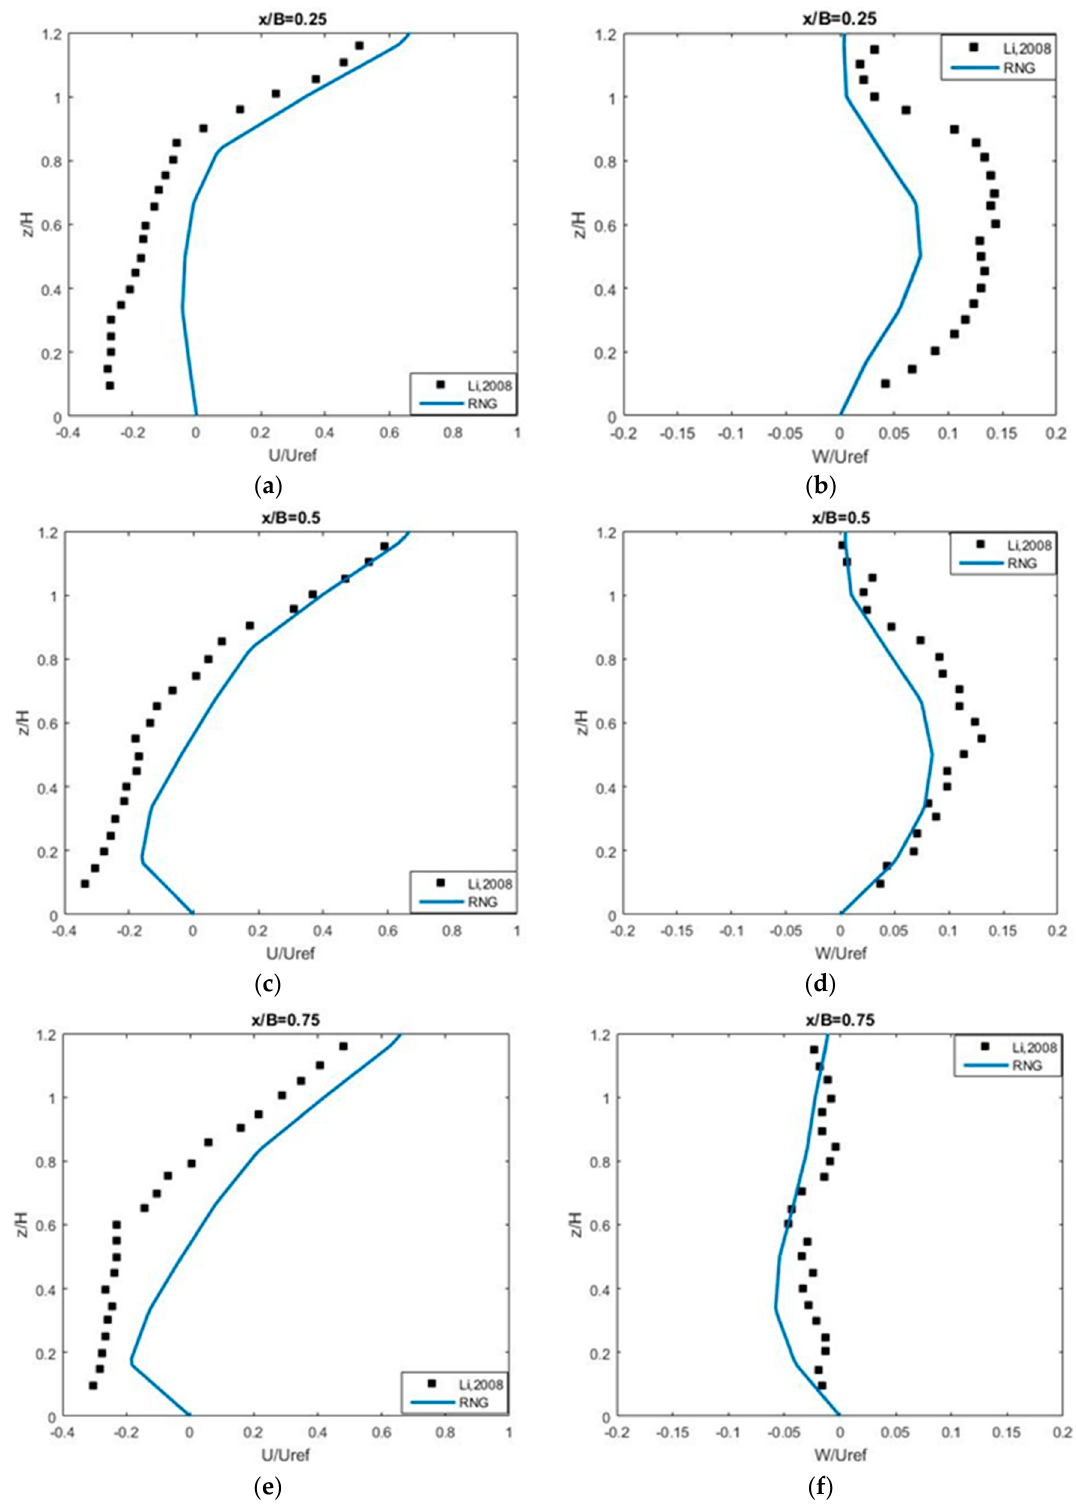
Figure 13. The vertical profile of normalized streamwise ( a , b , c ) and vertical ( d , e , f ) velocities with AR = 0.5.